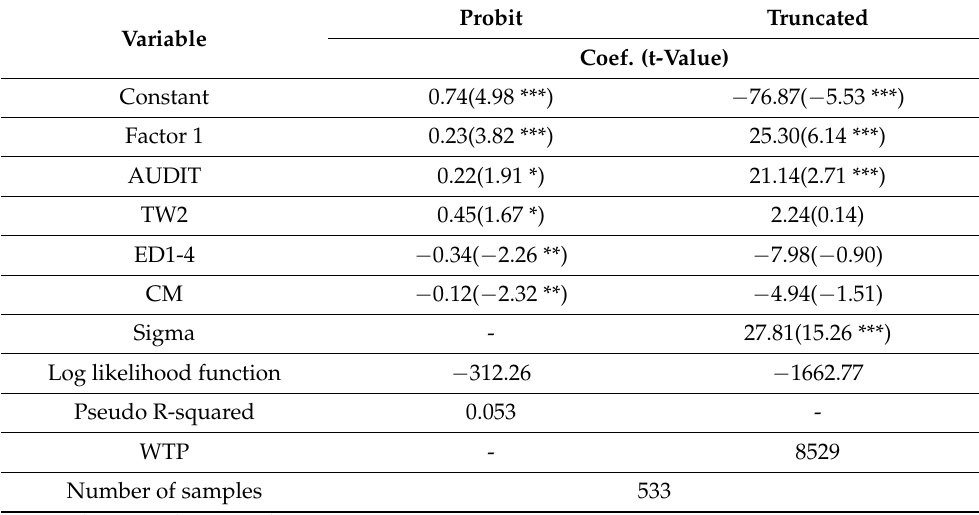
Table 13. Double-hurdle model calibration table for drunk motorbike drivers.